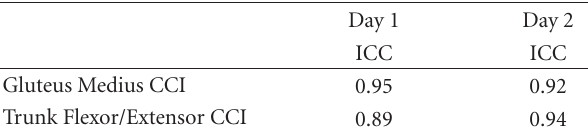
Table 5: Within-day repeatability for gluteus medius and trunk flexor/extensor cocontraction index during standing.